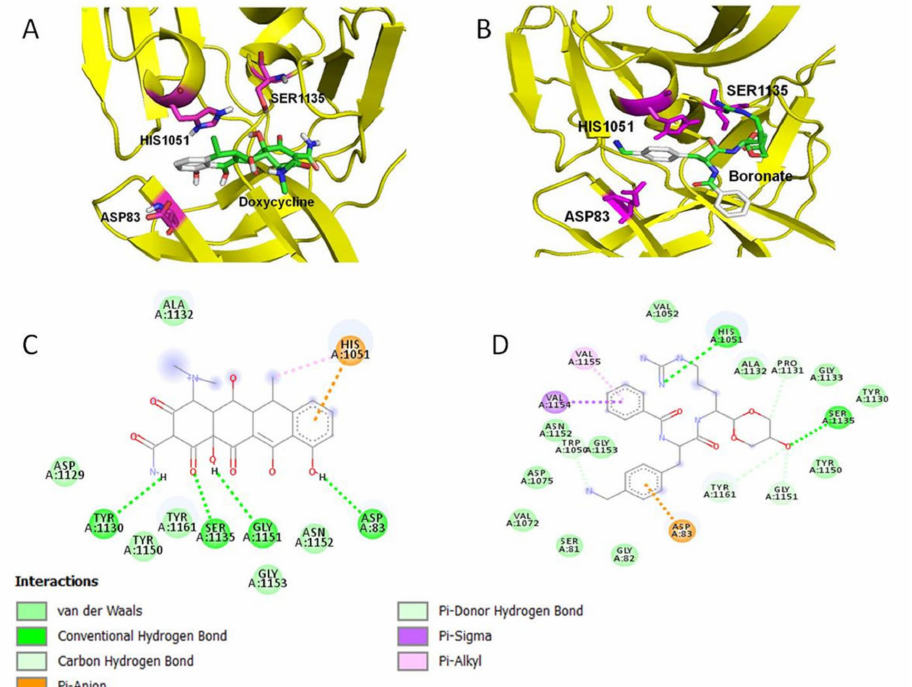
Figure 1. Small-molecule–protein docking of the interaction between doxycycline and ZIKV protease. ZIKA NS2B-NS3pro (PDBID:5lc0) was downloaded from Protein Data Bank (https://www.rcsb.org/, accessed on 5 March 2021) and minimized in Gromacs v5.1.4. using the GROMOS96 43a1 force field, and docking simulations were performed by using AutoDock Vina Version 2.0. ( A , B ) Doxycycline and boronate, were docked into the active site of viral protease as a standard. The binding of doxycycline to ZIKA NS2B-NS3 pro is generated by four hydrogen bonds with the protease catalytic triad residues TYR 1130, SER 1135, GLY1151 and ASP83. ( C ) The binding of doxycycline to ZIKA NS2B-NS3 pro is generated by four hydrogen bonds with the protease residues TYR 1130, SER 1135, GLY1151, and ASP83. ( D ) The binding was observed with the boronate but with fewer hydrogen bonds compared to doxycycline.